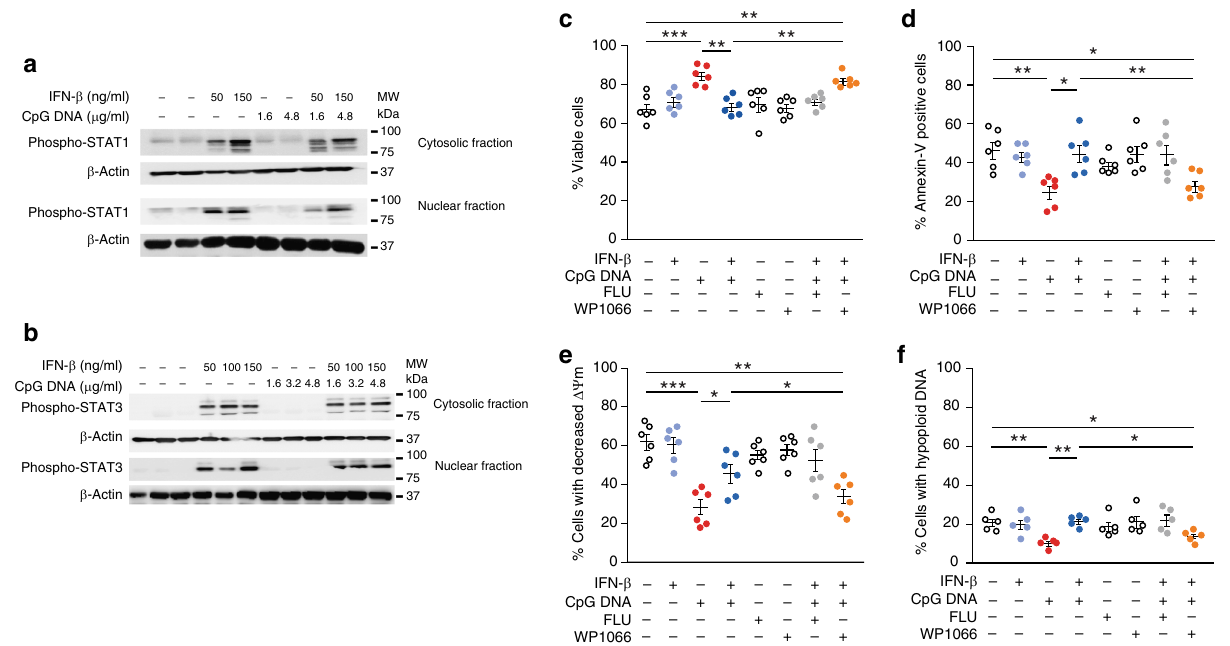
Fig. 5 IFN- β promotes neutrophil apoptosis through STAT3 activation. a , b Human PMN (5*10 6 cells/ml) were pretreated with human IFN- β (50 – 150ng/ml) for 10min and then challenged with CpG DNA for 30min. The cells were then lysed, cytosolic and nuclear fractions were prepared and immunoblotted for phospho-STAT1 ( a ) or phospho-STAT3 ( b ). β -actin served as a loading control. Blots are representative for 3 independent experiments. c – f Human PMN were pre-incubated with the STAT1 inhibitor fl udarabine (FLU; 25 μ M) or the STAT3 inhibitor WP1066 (5 μ M) for 30min before addition of human recombinant IFN- β (50ng/ml) for 10min and then challenged with CpG DNA. After culture for additional 24h, cell viability ( c ), annexin-V staining ( d ), mitochondrial transmembrane potential ( ΔΨ m, CMXRos staining) ( e ) and nuclear DNA content ( f ) were analyzed. Results are mean±SEM of 6 experiments with